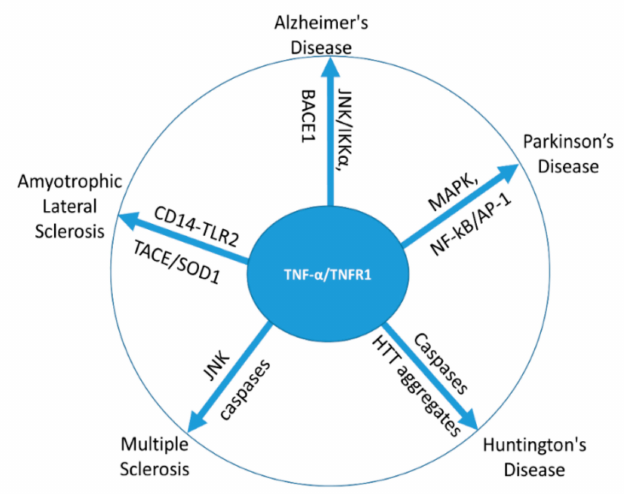
Figure 2. Involvement of TNF- α in various neurological disorders via action on di ff erent